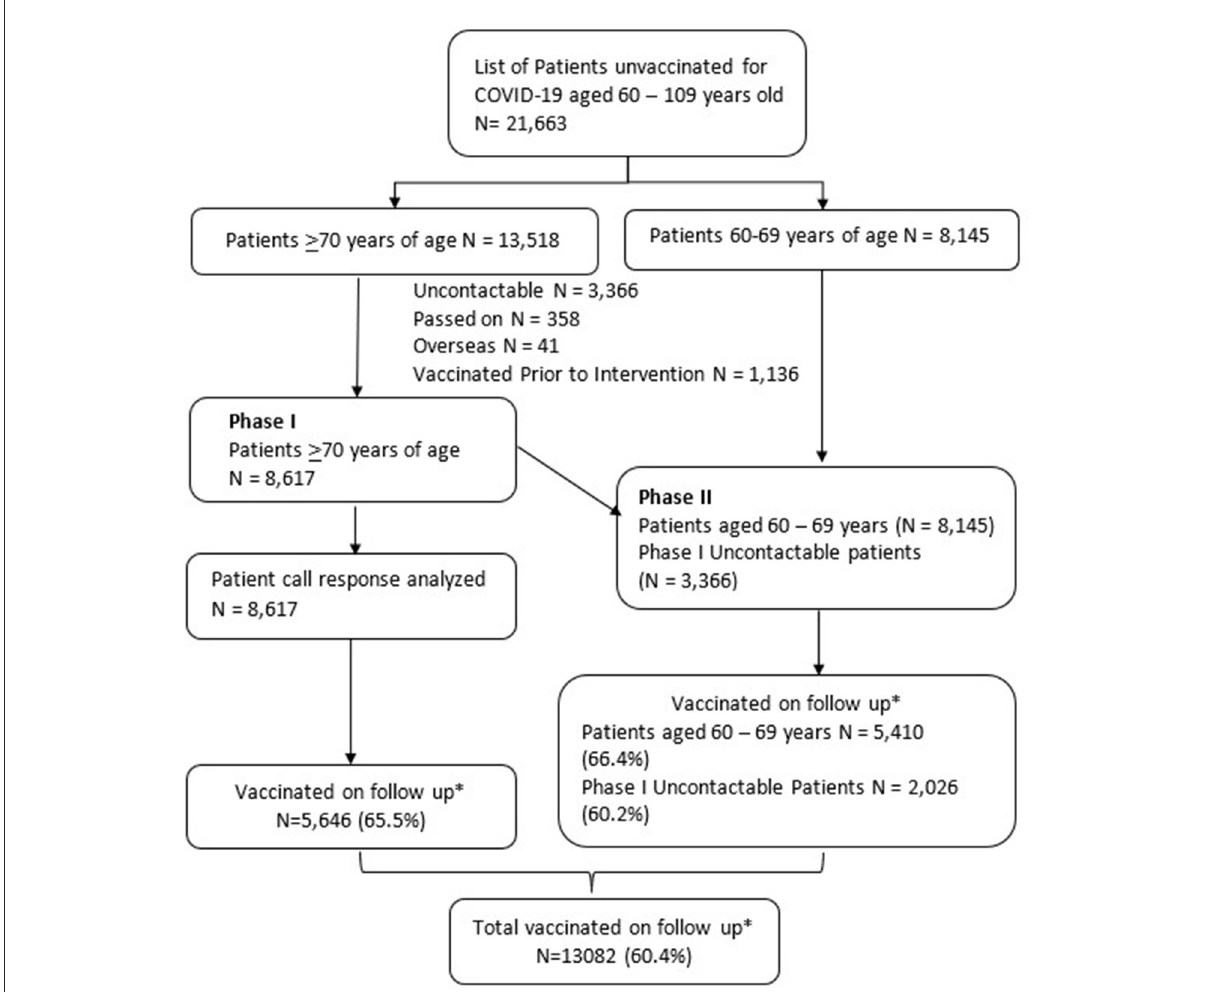
FIGURE1 Flow chart for COVE (COVID-19 Vaccination in Elderly) program phases I and II. * Follow up done on 27 October 2021 (3 months after COVE 1 initiation). 1 COVE, COVID-19 Vaccination in